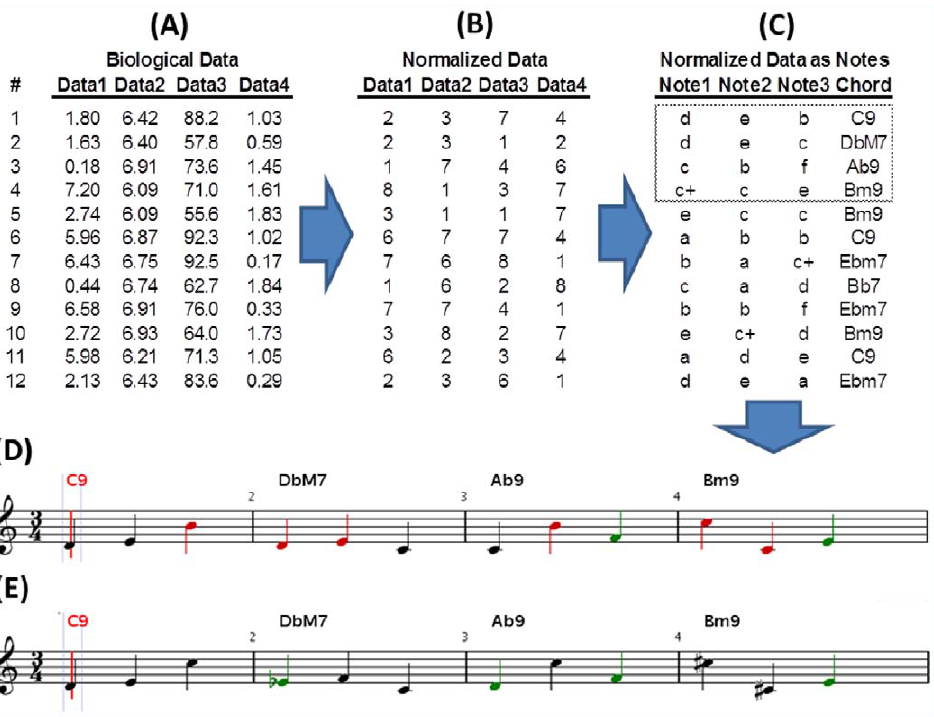
Figure 1. Microbial Bebop method summary. Using a small, hypothetical dataset (A), the general approach to Microbial Music is summarized. Data is first normalized to integer values (B). In this example, values between 1 and 8 were selected. Each integer value is mapped to a specific note or chord (C). The first four observations in (C), identified by dashed outline, are converted into four bars of musical notation in 3/4 time in (D). Chord notes are black, color tones are green, and tones that are dissonant to chord are red. Melody is rectified to harmony in (E). For implementation of rectifying melody to harmony, the freely available jazz improvisation program ‘ImproVisor’ (www.cs.hmc.edu/˜keller/jazz/improvisor/) [11] was used. Additional information can be included in resulting composition by incorporating note duration, instrument selection, or tempo as described in ‘Sample Compositions’.